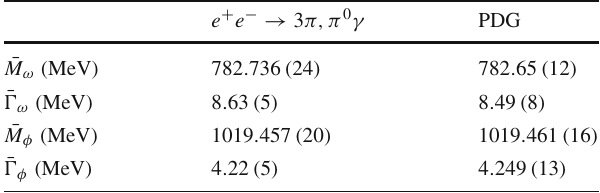
Table 6 Comparison of ω and φ resonance parameters from e + e − → 3 π,π 0 γ to the PDG values, including VP